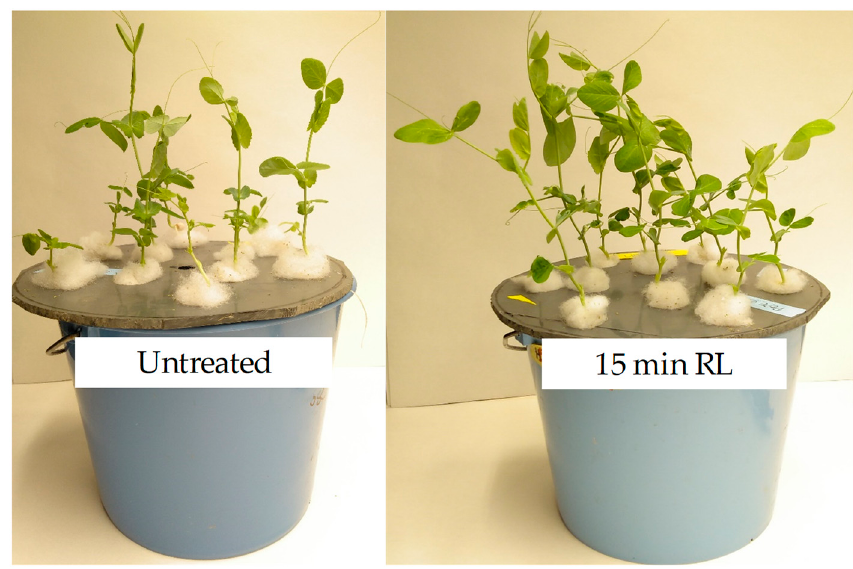
Figure 6. Image of 3-week-old pea plants after 15 min red light treatment of the seeds. Ten seedlings were transferred per pot and maintained in Hoagland’s solution.